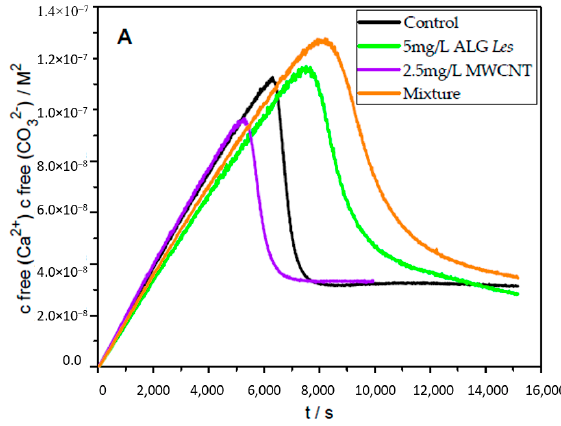
Figure 7. Time development of CaCO 3 solubility products using 2.5 mg/L MWCNT-COOH at pH 9.0: control ( black line ) and 2.5 mg/L ( red line ).